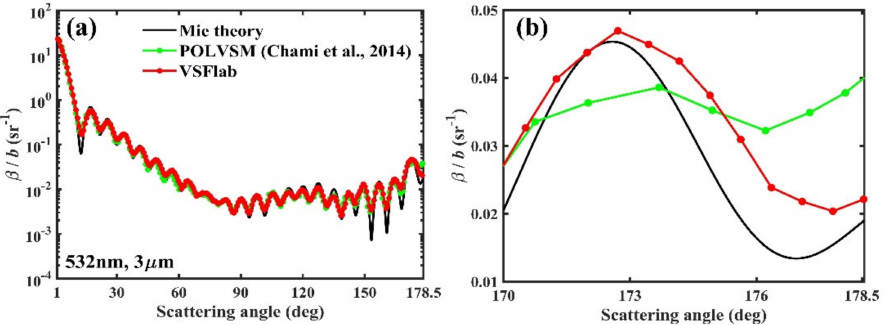
Figure 6. ( a ) Comparison of phase functions for 3 µ m beads at 532 nm obtained from the VSFlab (red line), redrawn from Chami’s work (green line) and calculated by Mie theory (black line). ( b ) Same as ( a ) but for angles between 170 ◦ and 178.5 ◦ .